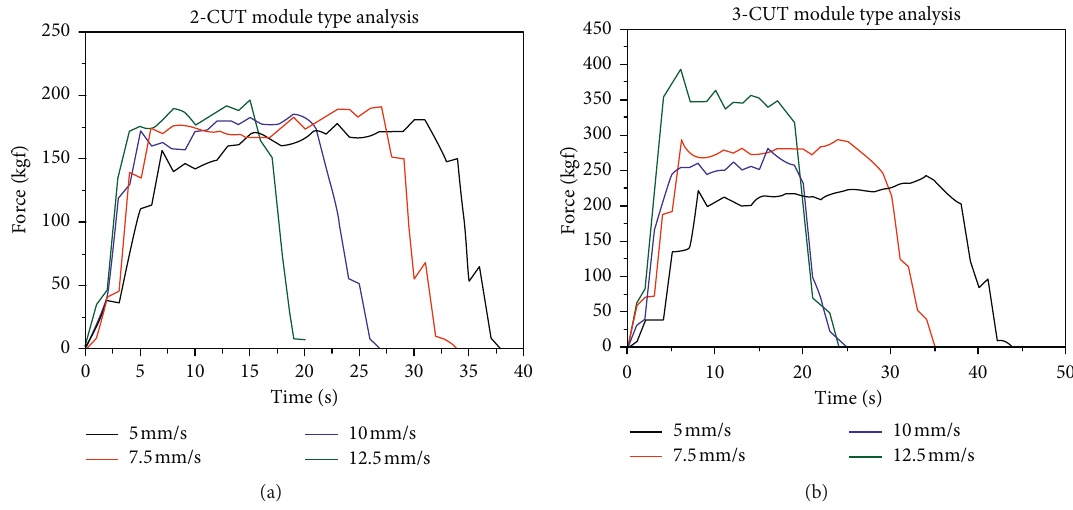
Figure 8: Variation in forces (kgf) on the 2-CUT and 3-CUT blade modules: (a) 2-CUT module; (b) 3-CUT